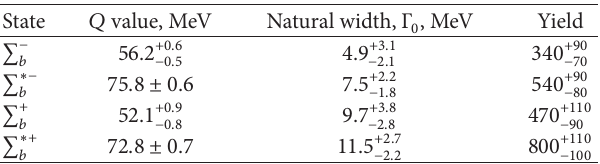
Table 1: Summary of the results of the fits to the 𝑄 = 𝑀(Λ 0 𝑏 𝜋 ± ) − ) − 𝑚 𝑀(Λ 0 𝜋 spectra from CDF 𝑏